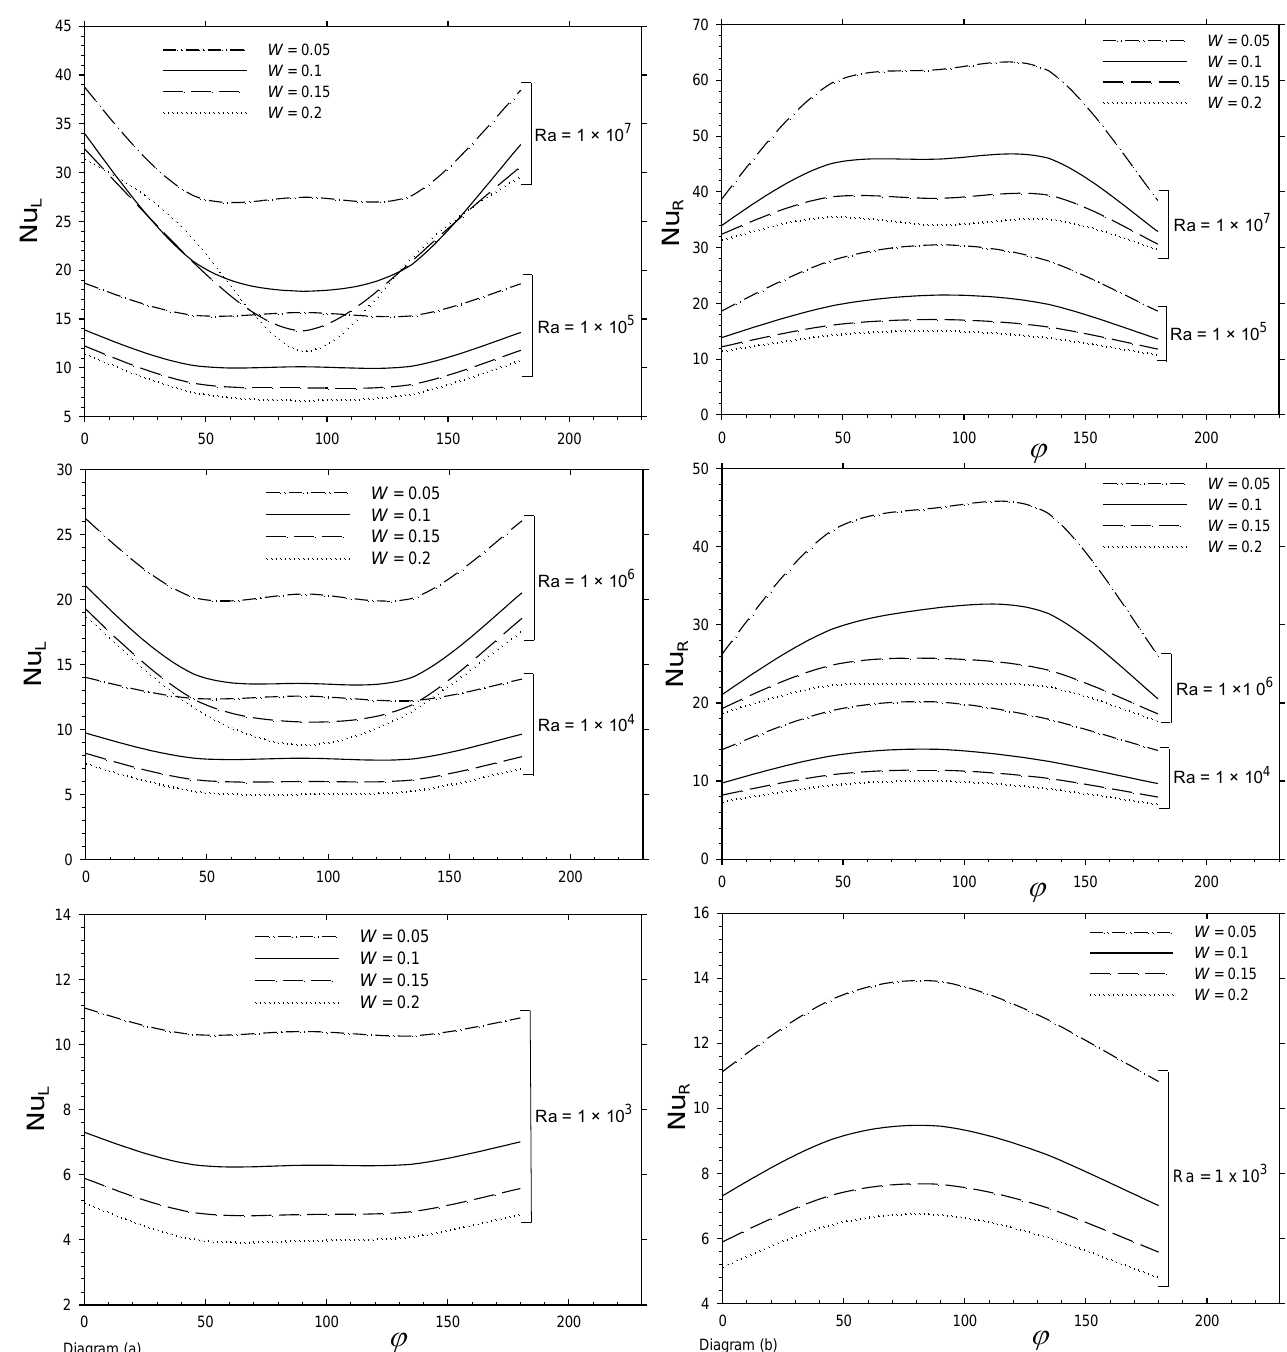
Figure 14. Variations in the mean Nusselt number of a slender cuboid with inclination ϕ for different Ra and W for ( a ) left-side and ( b ) right-side